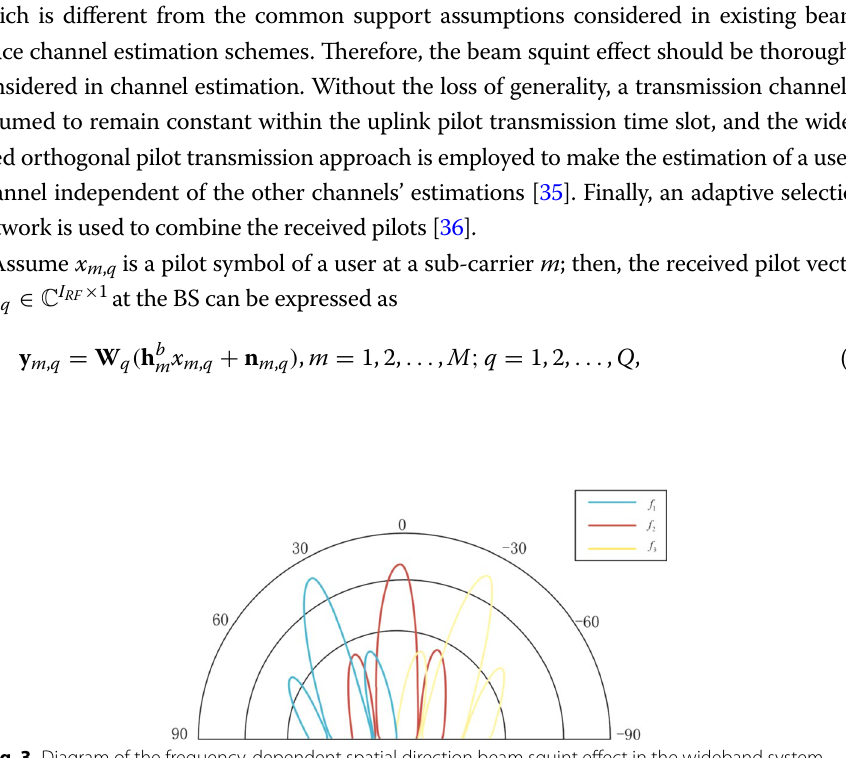
Fig. 3 Diagram of the frequency-dependent spatial direction beam squint effect in the wideband